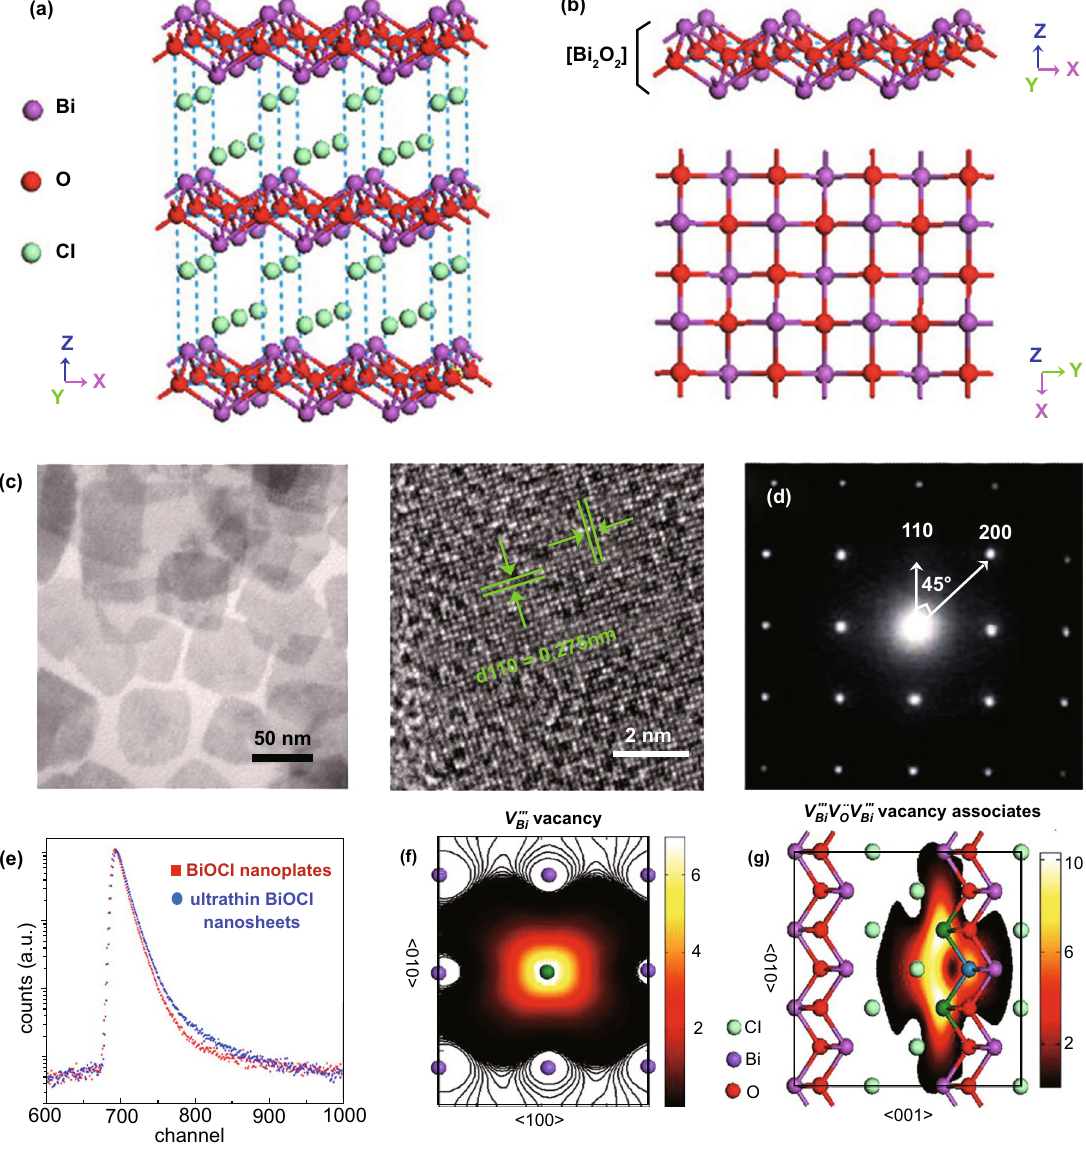
Fig. 14 Scheme showing the crystal structure of BiOCl. a 3D‑projection. b , c [Bi 2 O 2 ] 2+ layers along with the [010] and [001] directions, cor‑ respondingly. d TEM/HR‑TEM of BiOCl NSs. e Positron lifetime spectra of ultra‑thin BiOCl NSs and BiOCl NPs. f , g Scheme showing trapped positrons of VBi ″′ defect and VBi ″′ VO ·· VBi ″′ ‑associated vacancy, correspondingly. Adapted with permission from Ref.